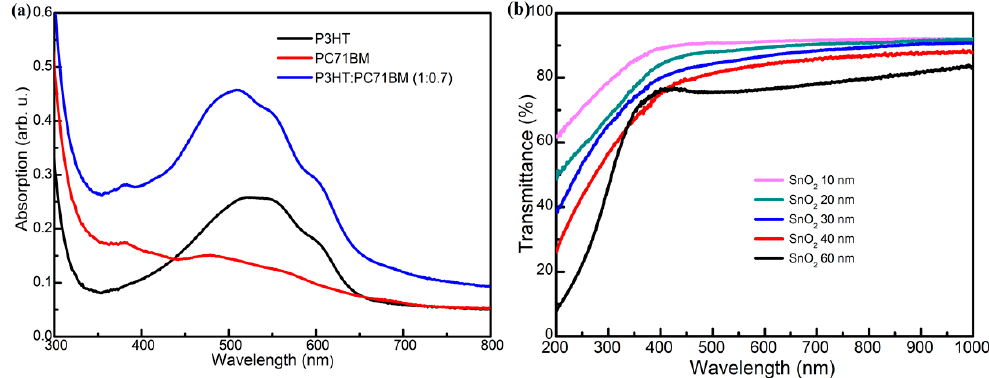
Figure 3. ( a ) Absorption spectra of P3HT:PCBM deposited on glass substrate and ( b ) transmittance spectra of SnO 2 with different thicknesses deposited on quartz substrate.